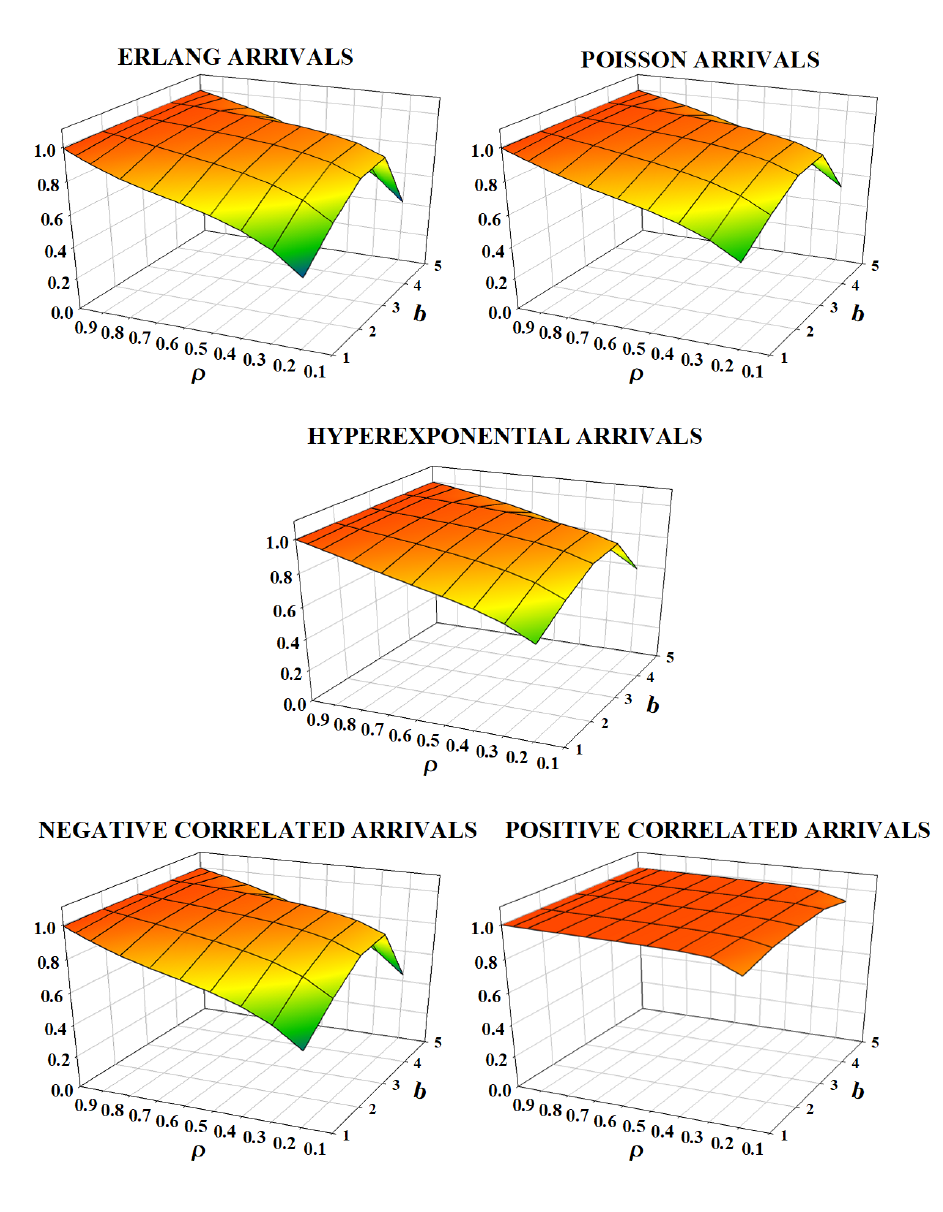
Figure 11. Spectral radius ( η ) of the matrix R for example